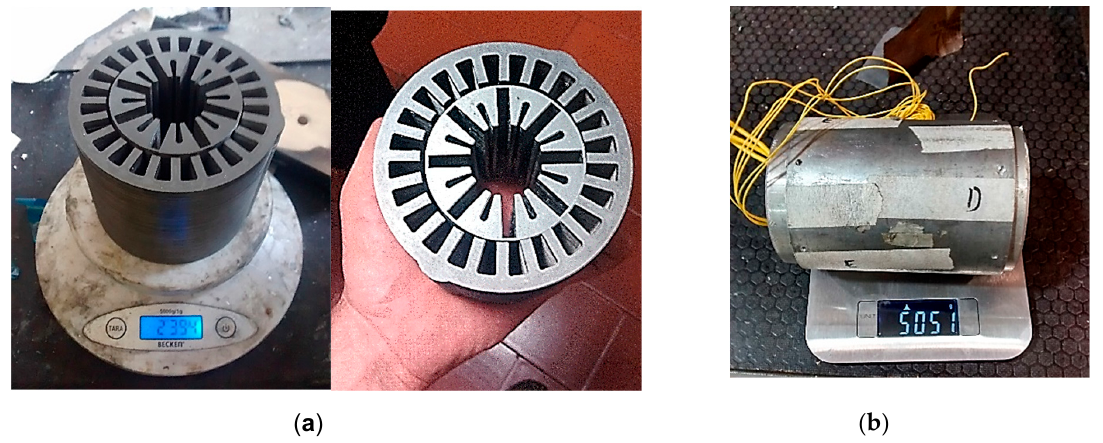
Figure 17. Shaft and rotor designs: ( a ) final shaft design and ( b ) ultimate rotor’s magnetic circuit.